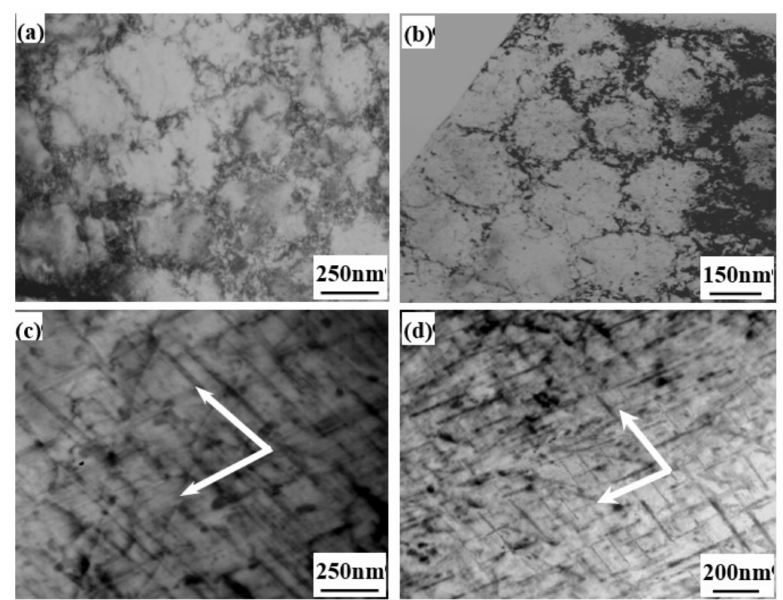
Figure 7. Dislocation configurations in Al-9Si-4Cu-0.4Mg-0.3Sc alloys after fatigue failure (arrows indicate the direction of slip bands). ( a ) Metal-mold cast alloy under ∆ ε t / 2 = 0.45%; ( b ) die-cast alloy under ∆ ε t / 2 = 0.45%; ( c ) metal-mold cast alloy under ∆ ε t / 2 = 0.25%; and ( d ) die-cast alloy under ∆ ε / 2 = t